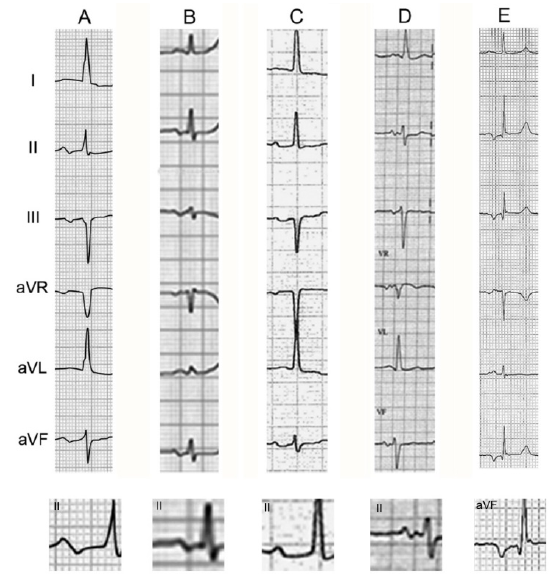
Figure 8. ( A ). Typical A-IAB. ( B ). Atypical A-IAB by duration. ( C ). Type 1 atypical A-IAB due to morphology. The P-wave is biphasic in leads III, and aVF, but the terminal component of the P wave in lead II is isodiphasic. ( D ). Type II atypical A-IAB. The P-wave is biphasic in leads III and aVF, but triphasic in lead II (+ − +). ( E ). Type III atypical A-IAB. The P-wave morphology is negative in leads III and aVF, and biphasic in lead II with the initial component of the P-wave in leads III and aVF isodiphasic. (Taken from reference 23).